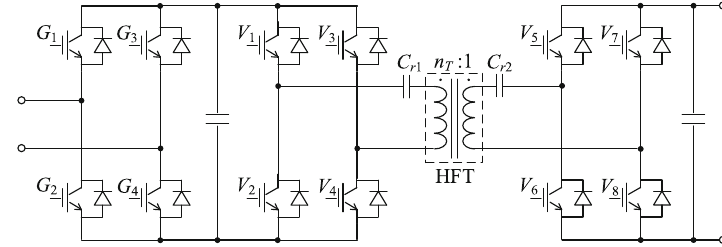
Fig. 3 PET cascaded unit sub-module